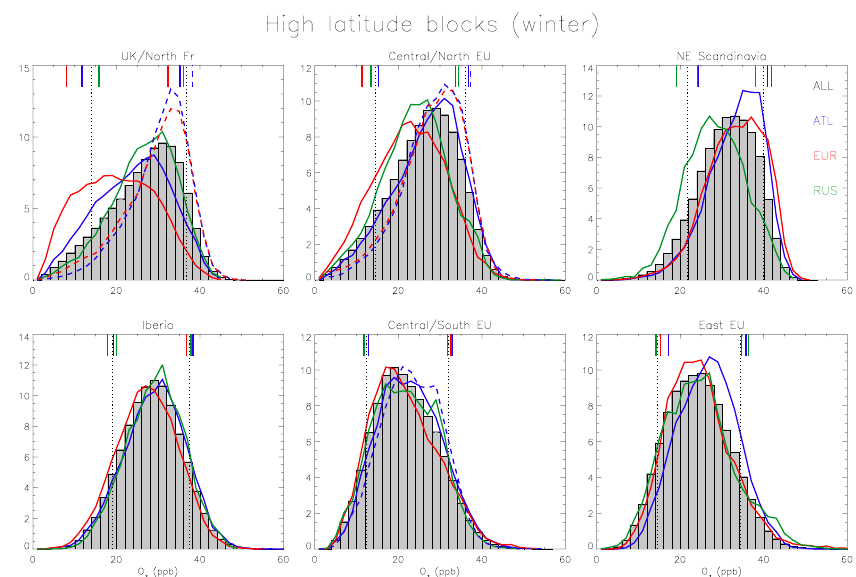
Figure 11. As Fig. 5 but for winter blocking. Note that blue and red dashed lines have been added to represent the frequency distributions of the data within the “UK/North Fr” and “Central/North EU” boxes when ridge centres are located over the ATL and EUR sectors, respectively. Data on days with ATL ridges are also shown for the “Central/South EU”